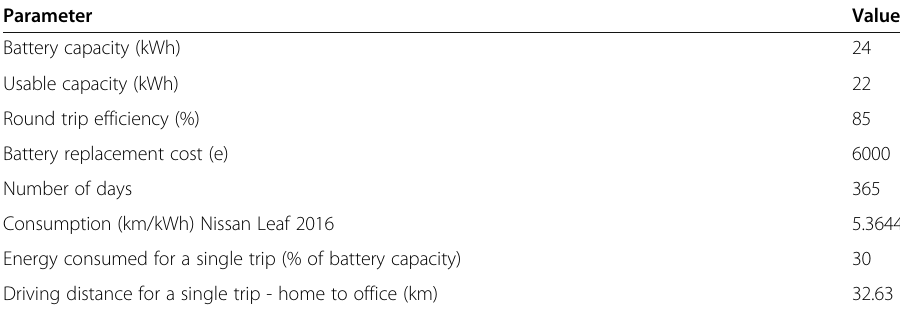
Table 4 Input parameters to the profit evaluation model